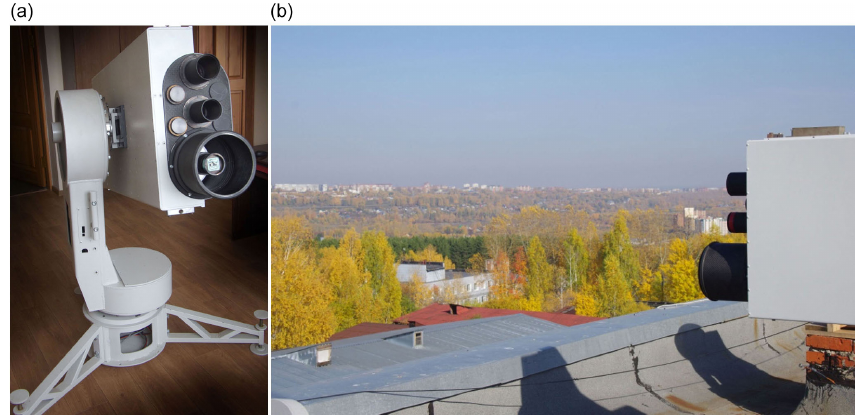
Figure 1. Photographs of the lidar on a rotary column in the laboratory room (a) and on the institute building roof (b) .